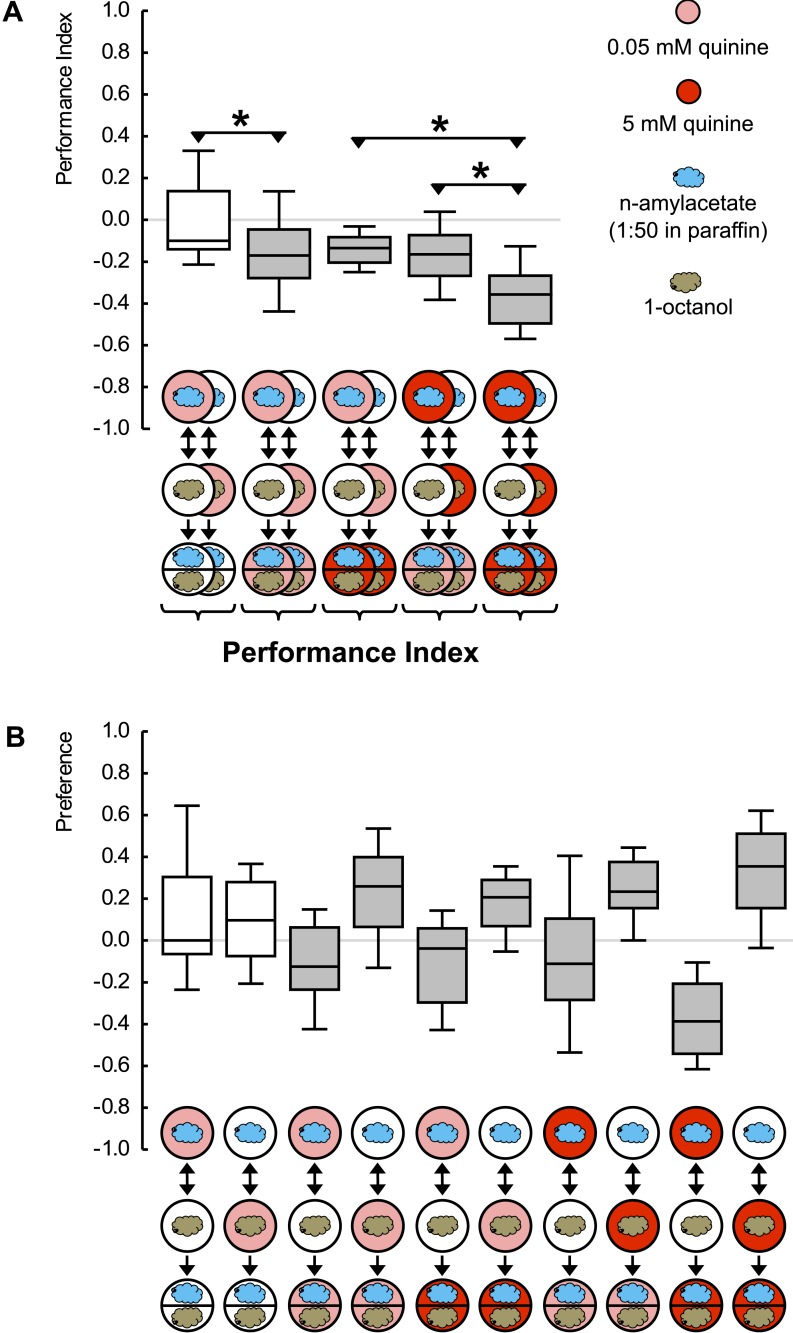
Quinine memory includes quinine strength.(A) Larvae are trained to associate one of two odors with a quinine punishment, using either a low (light red) or a high (dark red) concentration of quinine. Learned escape behavior is expressed if the testing conditions are as ‘bad’ as the training-punishment, or worse. In other words, neither the value of the training-punishment alone nor the value of the testing situation alone, determines the levels of learned behavior—but a comparison of them does. (B) Preference scores underlying the associative performance indices in (A). Sample sizes: 22–23. Shaded boxes in (A) indicate p < 0.05/5 from chance (one-sample sign-tests), in (B) pairwise differences between groups at p < 0.05/5 (Mann–Whitney U-tests). Asterisks in (A) indicate pairwise differences between groups at p < 0.05/3 (Mann–Whitney U-tests). For a detailed description of the sketches, see legend of Figure 1.